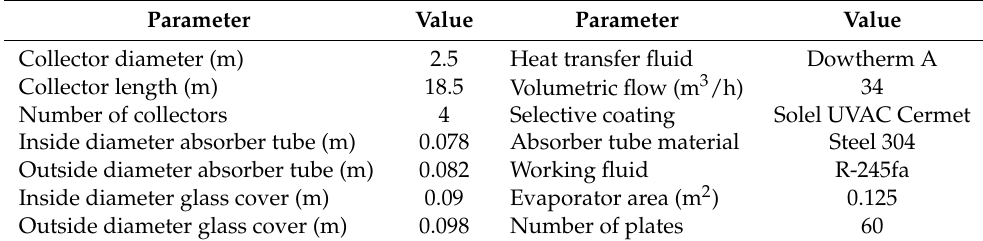
Table 7. Configuration of the Parabolic Trough Collectors (solar field).